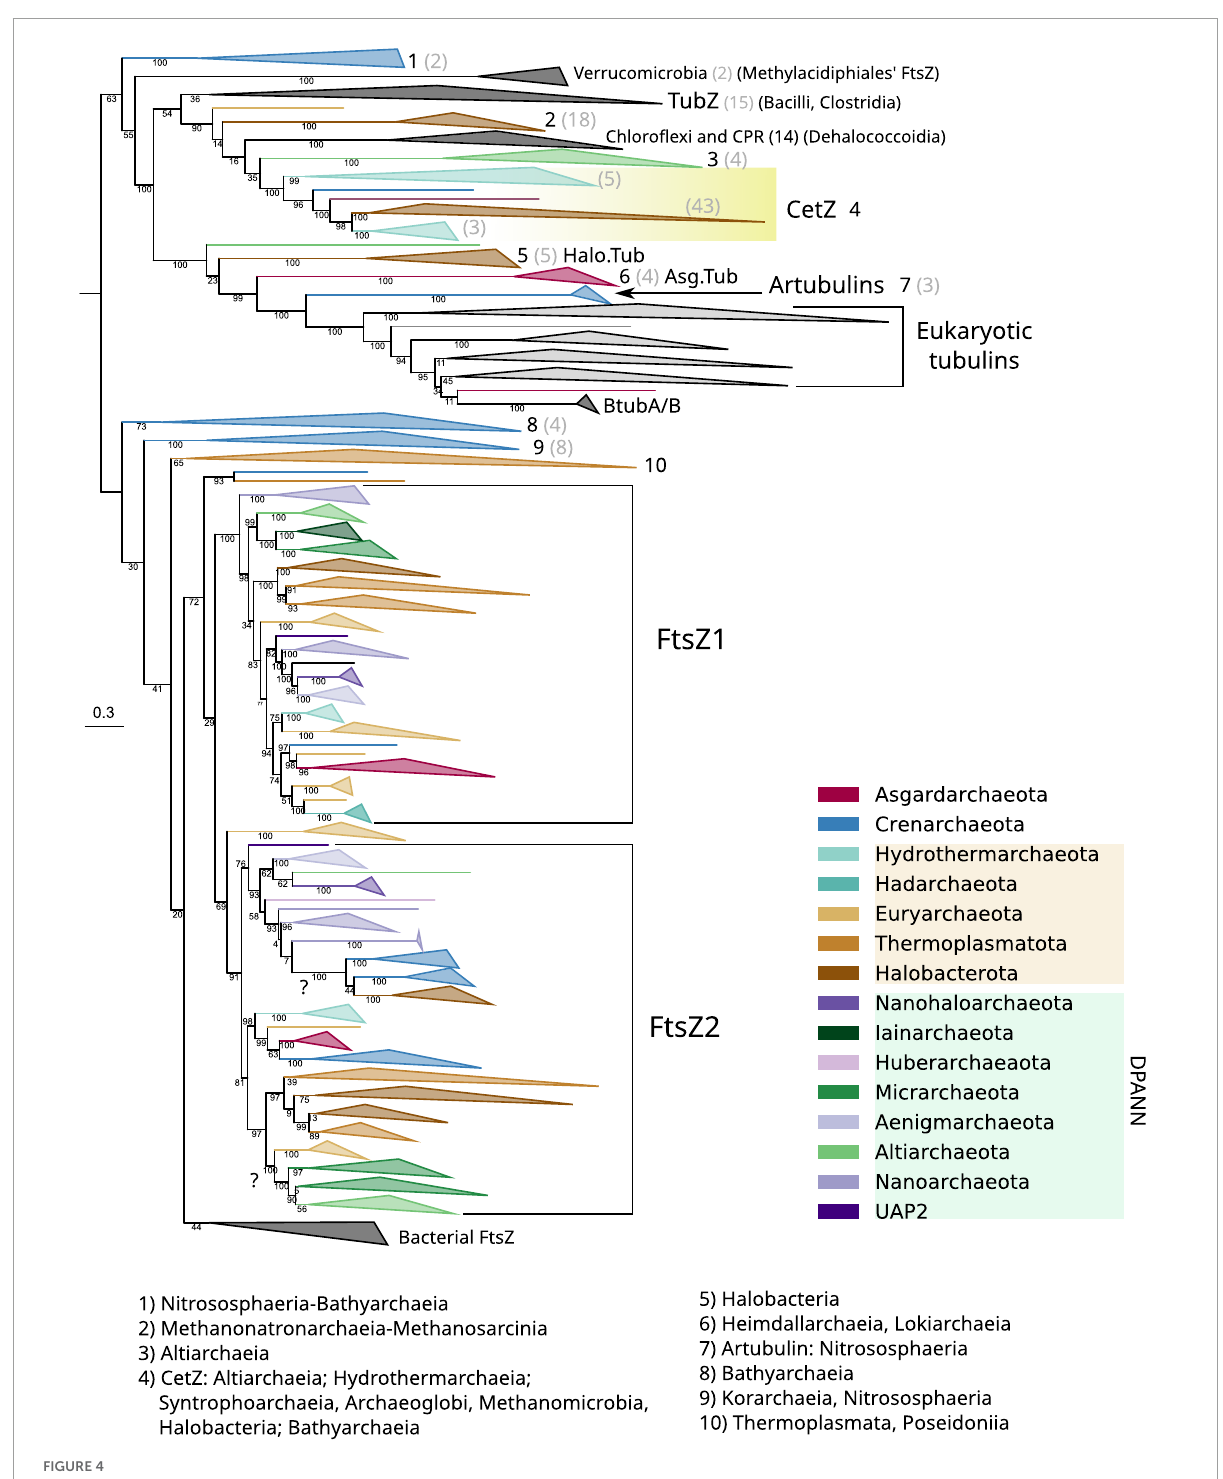
FIGURE4 Phylogeny of all members of the FtsZ/tubulin protein family centered on archaeal sequences. The tree was rooted at the mid-point. Branches are colored according to taxonomic phyla following GTDB nomenclature (release bac120, arc122). The dataset was constructed by a selection of representative bacterial FtsZs and eukaryotic tubulins, plus an archaeal selection based on redundancy filtering and adding back removed paralogs from the remaining taxa. The final MSA consisted of 1,637 sequences and 410 positions, trimmed with trimAl - gt 0.2. The phylogeny was built using IQ-TREE, automatic model selection (LG + R10), and ultrafast bootstrap (UFBoot2). Numbers indicate the taxonomic composition of each phylogenetic group shown at the bottom, and gray numbers between parenthesis are the number of sequences for the respective group. Refer to the extended tree in Supplementary Figure 4